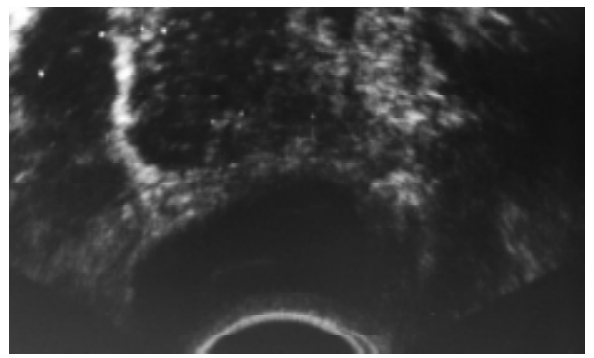
Figure 4 – Transrectal ultrasonography showing a prostatic ab- scess with periprostatic extension.